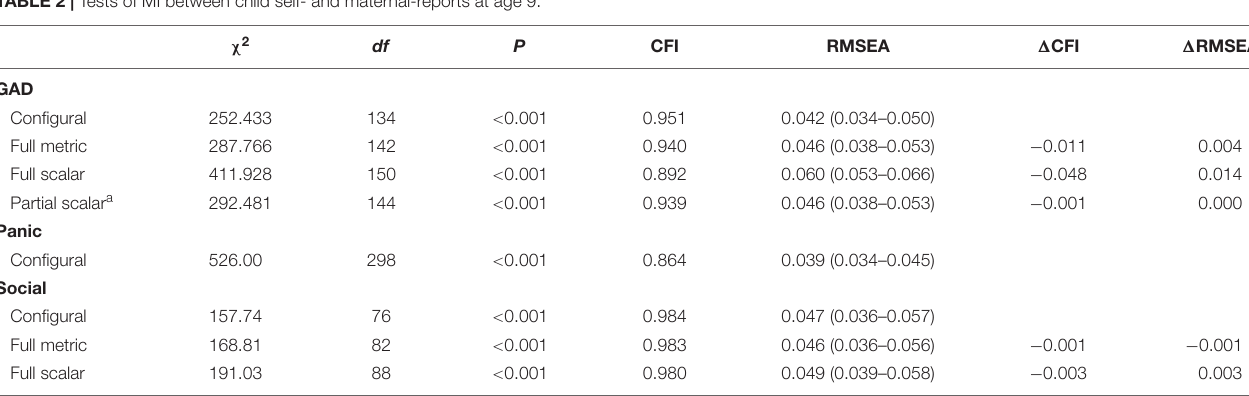
TABLE 2 | Tests of MI between child self- and maternal-reports at age